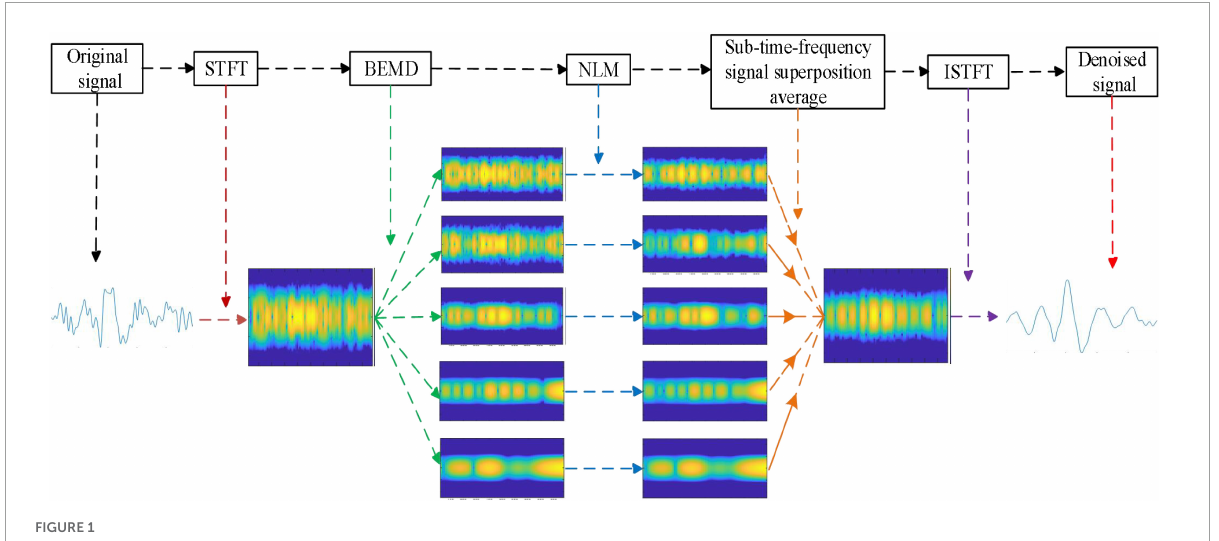
FIGURE1 The time-frequency denoising algorithm